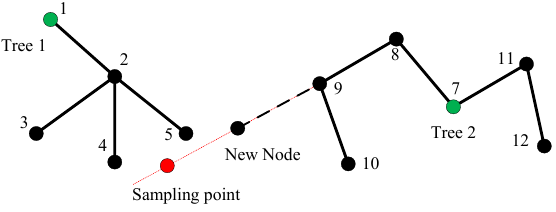
Figure 5. The connecting process of two separated